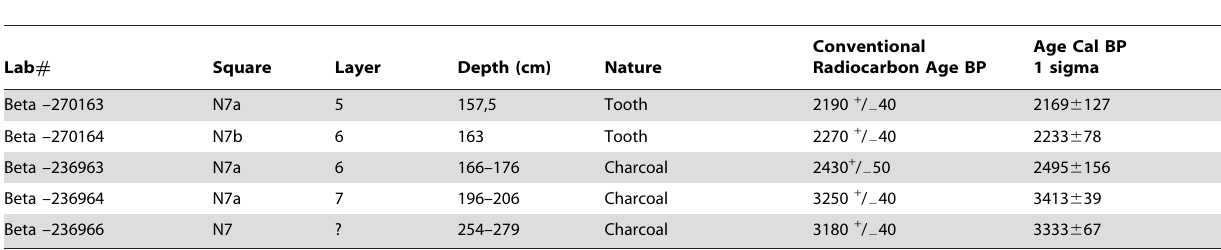
Table 4. 14 C dates at Leopard cave (calibration curve: SHCal 04 [71], using OxCal 4.1).